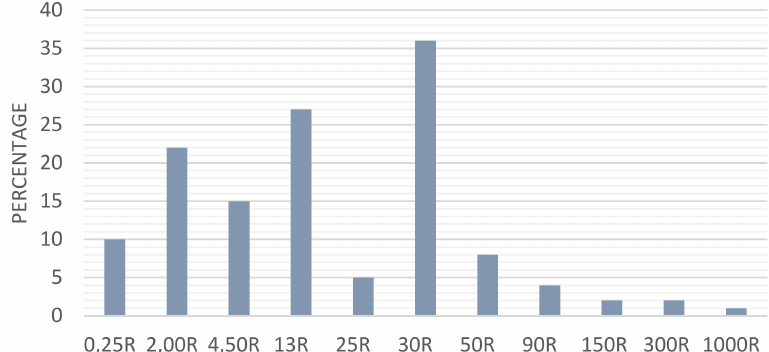
Figure 5. Percentage distribution of grid resolutions (in meters).